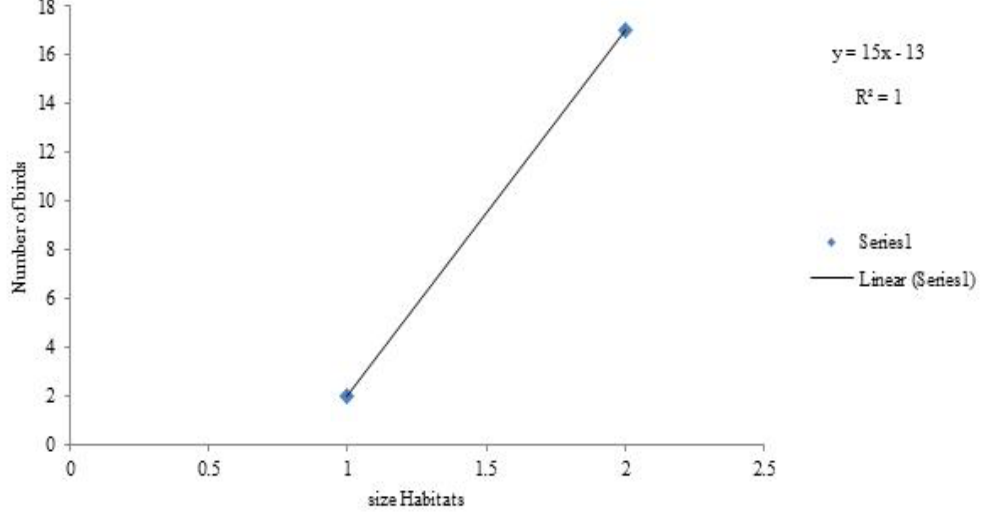
Fig. 4: Regression of the number of birds occupied on both dumpsite and sewage stabilization